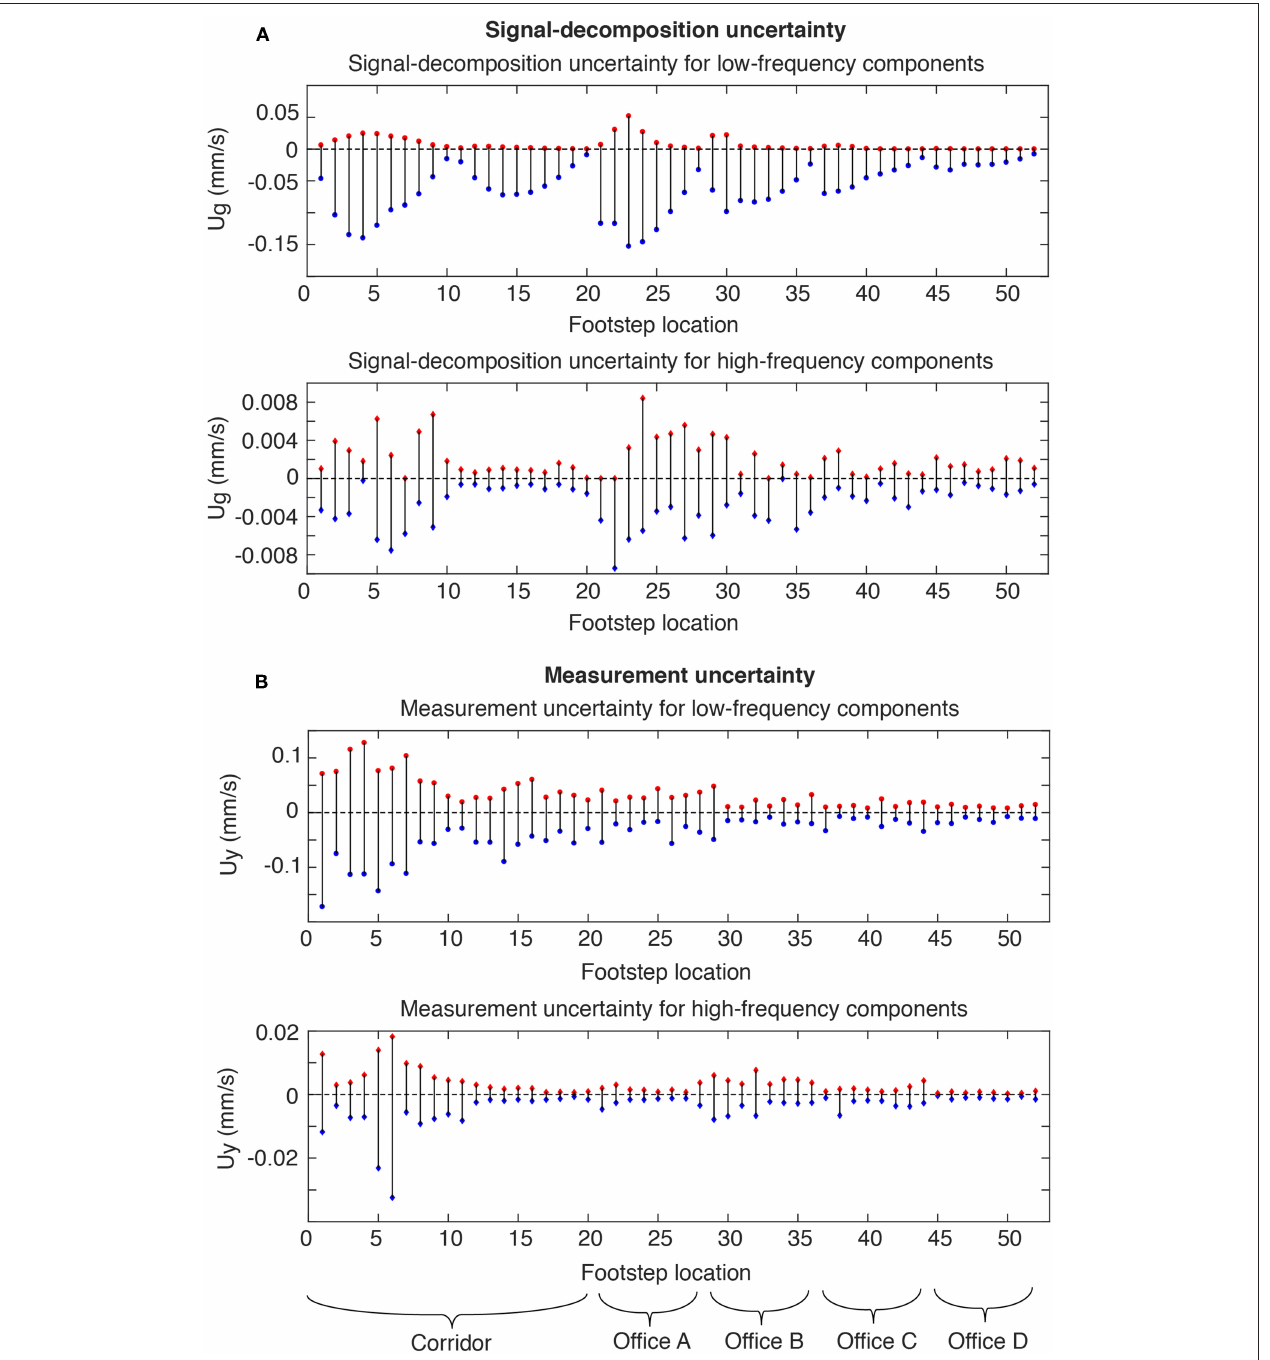
FIGURE 7 | Model and measurement uncertainties for each potential footstep-impact location. (A) Presents signal-decomposition uncertainty for low-frequency components for Sensor S1 are estimated by taking the difference between simulated footstep-signal components at frequency ranges that lay between 16 and 48Hz and components at frequency range [20, 40] Hz. Similarly, Signal-decomposition uncertainty for high-frequency components for Sensor S1 are estimated by taking the difference between simulated footstep signal components at frequency ranges that lay between 126 and 271Hz and components at frequency range [150, 200] Hz. (B) Presents measurement uncertainty for Sensor S1 at each footstep location are estimated from 10 independent trajectory measurements conducted prior to location identification. Wavelet decomposition is carried out in the frequency range [20, 40] Hz for low-frequency components and [150, 200] Hz for high-frequency